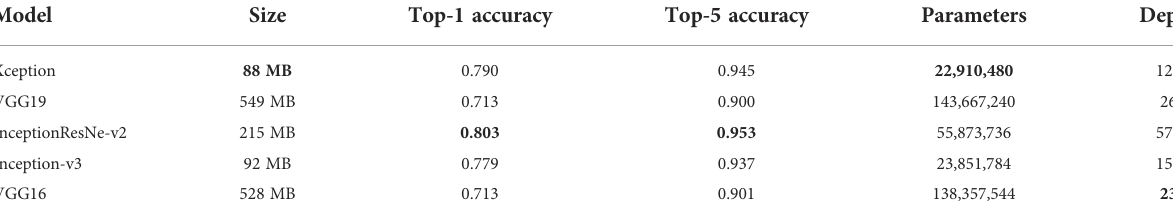
TABLE 2 Comparison of the imagenet architectures used in